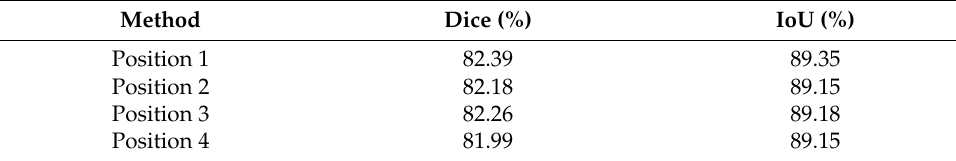
Table 2. Ablation experiments on the ISIC2018 dataset.